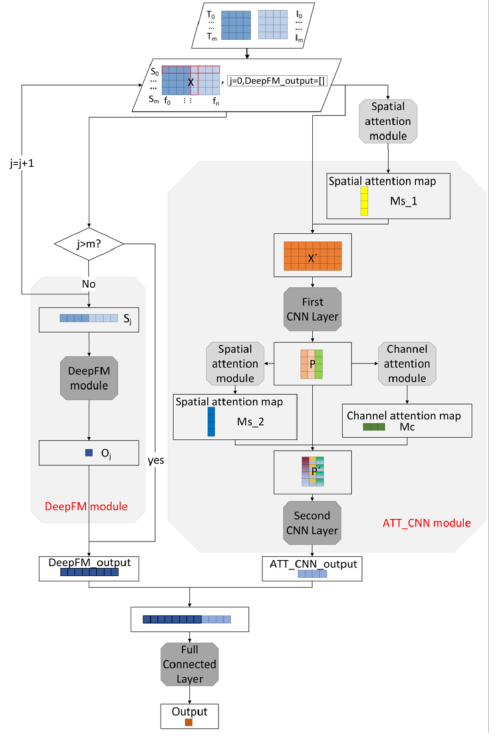
Figure 2. The prediction process of the FA-CNN